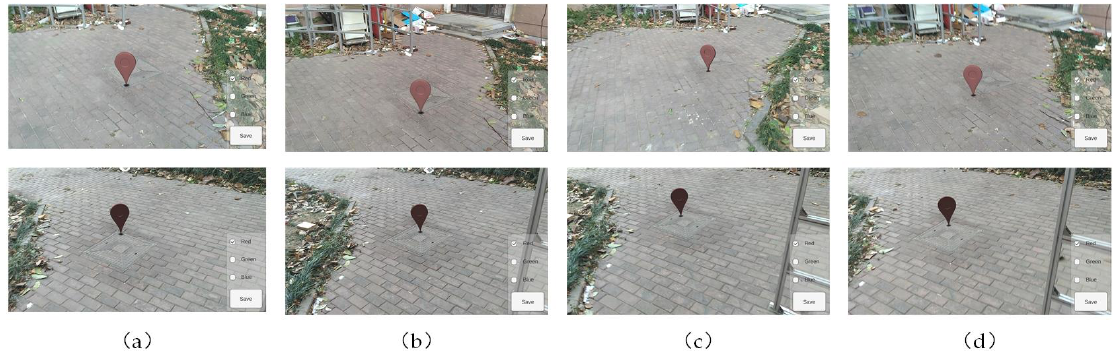
Figure 10. Positions of arrows at different times and two different angles: ( a ) at the 1st min; ( b ) at the 5th min; ( c ) at the 9th min; ( d ) at the 13th min. Table 3. Translation of pipelines in 13 min.